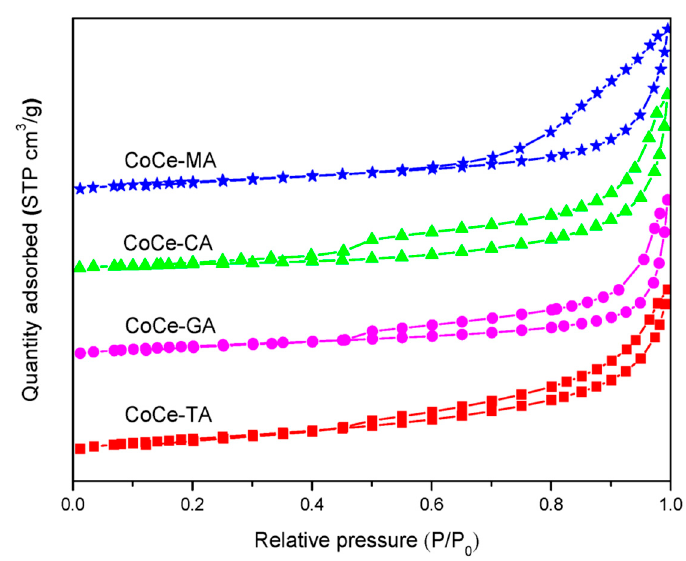
Figure 3. N 2 adsorption and desorption isotherms of the CoCe–X catalysts.